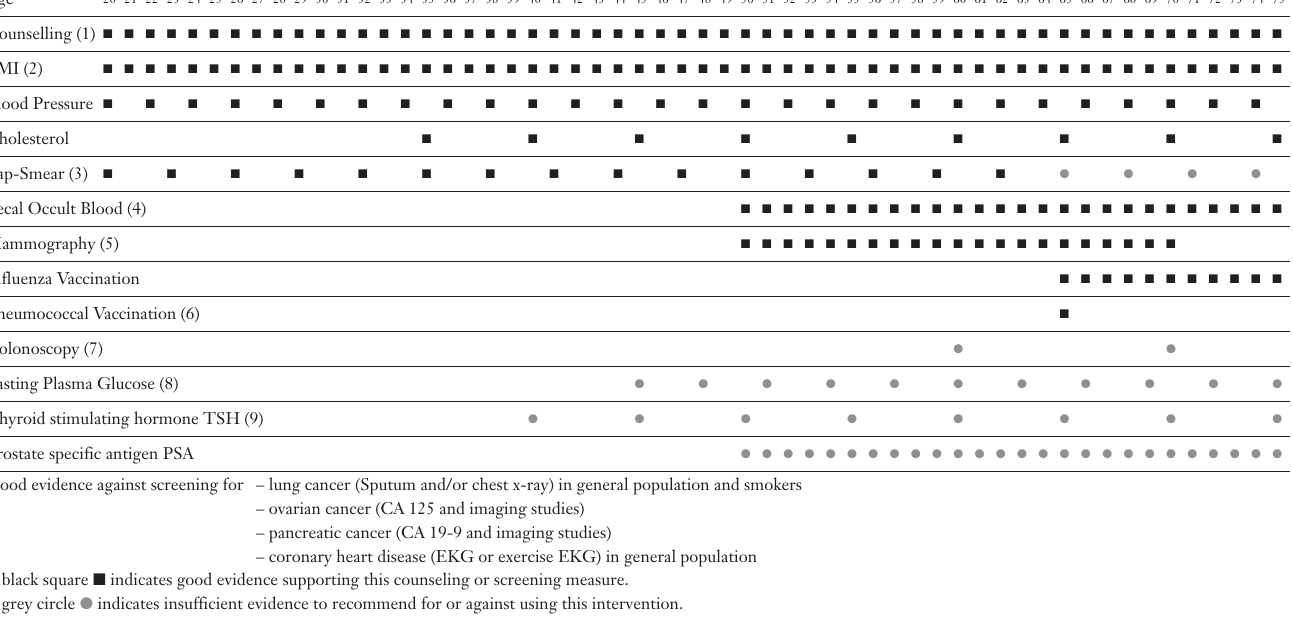
Selected, age-specific preventive interventions with strength of supporting evidence. Adapted from